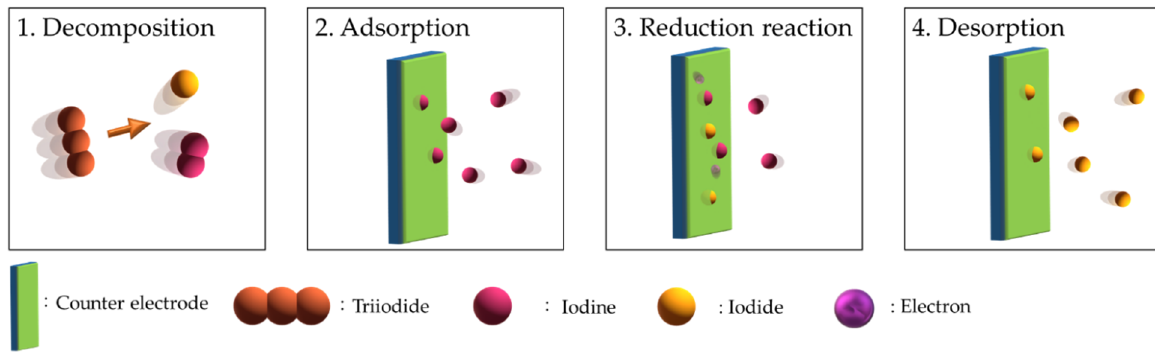
Figure 2. The schematic diagram of the electrochemical regeneration reactions of I 3 − ions at a counter